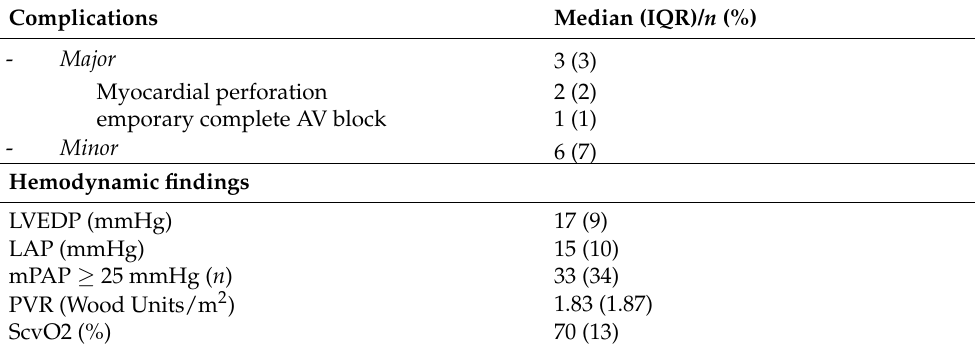
Table 2. Hemodynamic findings and periprocedural complication during CC with RV-EMB. Abbrevi- ations: LVEDP = leftend-diastolicpressure, LAP = leftatrial pressure, mPAP = meanpulmonary artery pressure, PVR = pulmonary vascular resistance, CI = cardiacindex, ScvO2 =